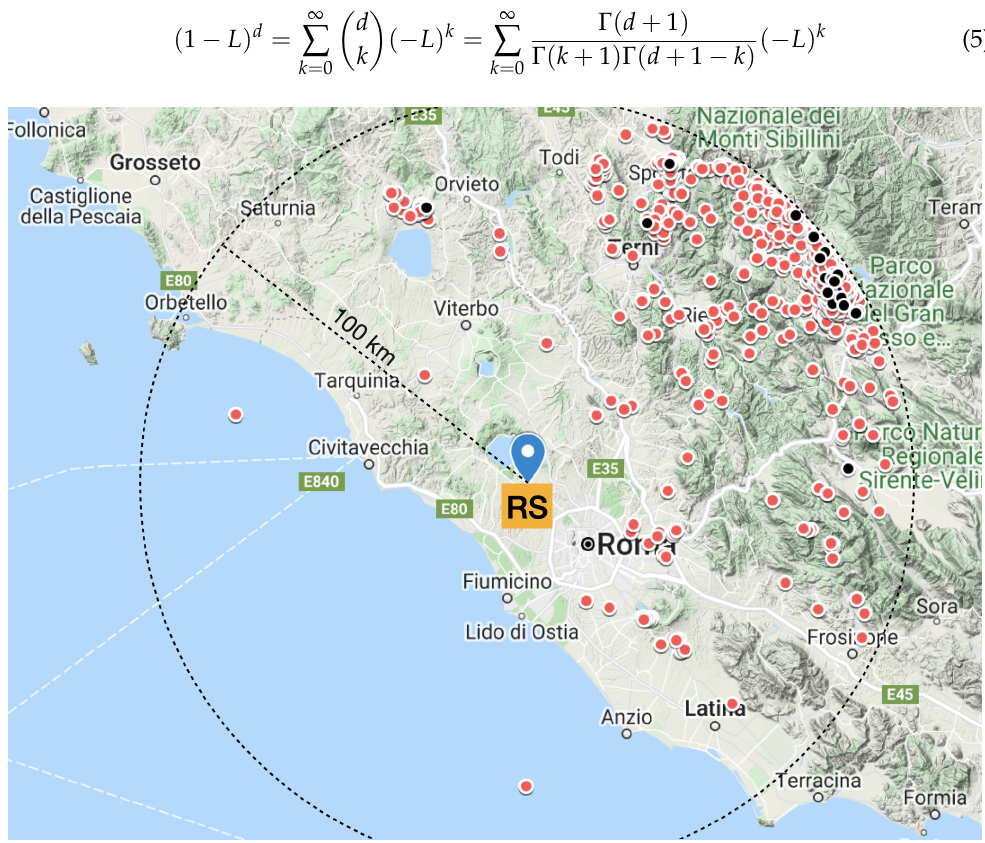
Figure 2. Distribution of seismic events around the RS detector. The Z axis represents the number of events, and the black points are the seismic events chosen to test the analysis method (Credits: Google My